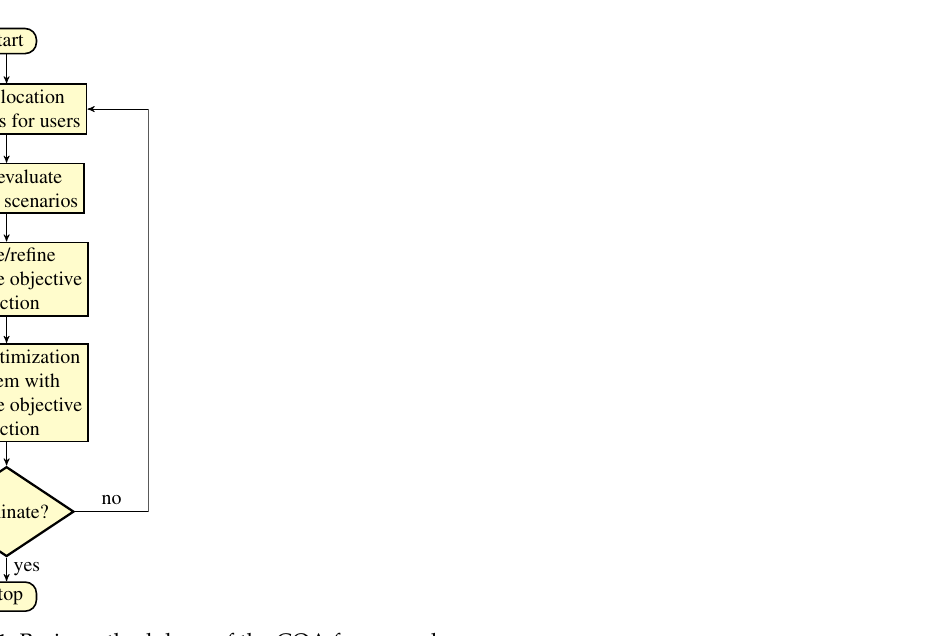
Figure 1. Basic methodology of the COA framework. Figure 2 exemplifies how the evaluation of a location scenario may look from the perspective of a user.